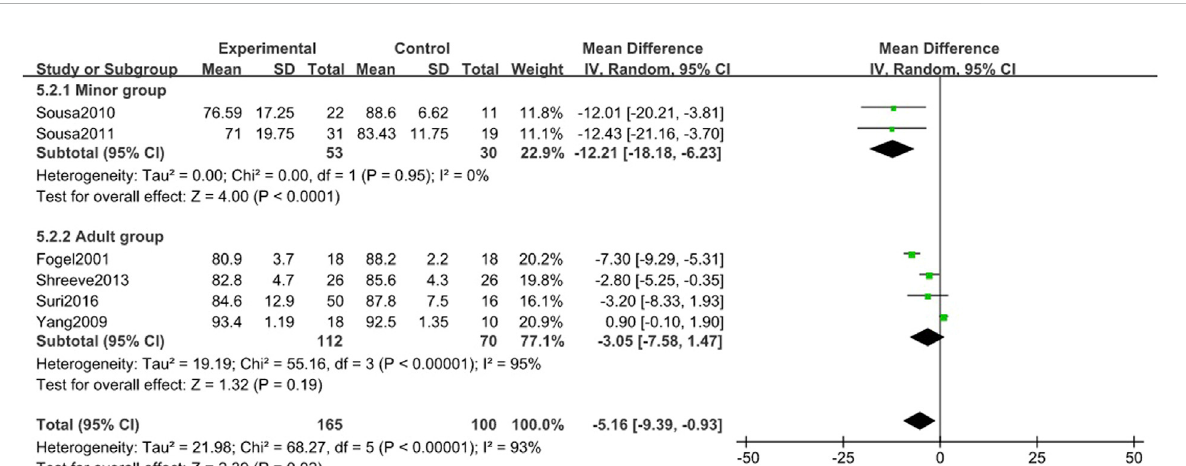
FIGURE 9 Forest plot of sleep ef fi ciency correlation between PCOS group and control group (age subgroup).